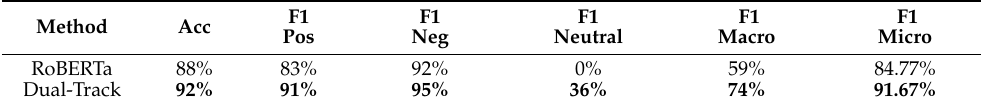
Table 7. Dual-track sentiment classification for iPhone 11 (LFSC-A). Method